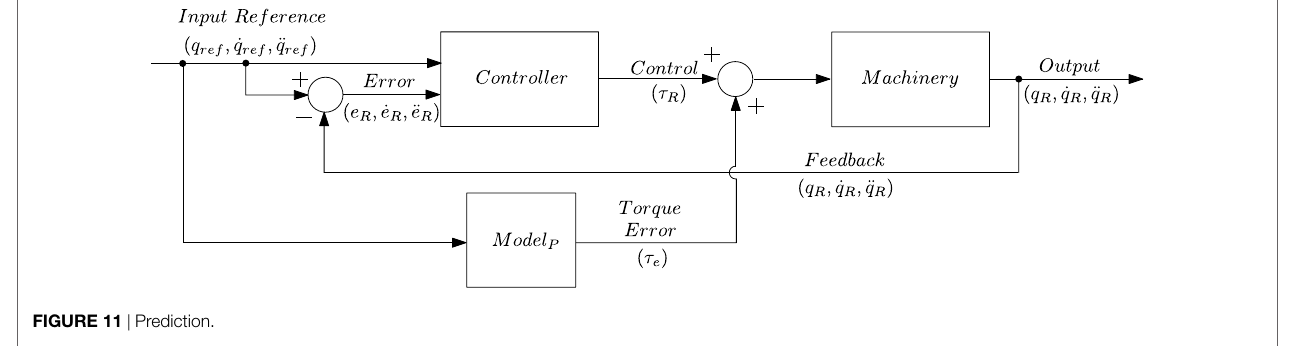
FIGURE 11 | Prediction.